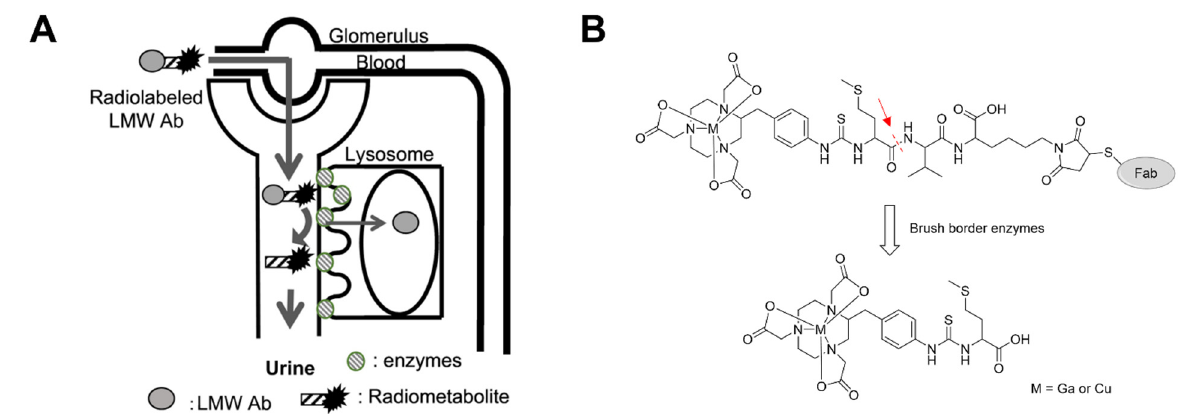
Figure 3. Renal brush border enzyme strategy. ( A ) The renal radioactivity levels of radiolabeled low molecular weight (LMW) Abs are reduced from early post-injection time by liberating a radiolabeled compound (radiometabolite) of urinary excretion from the parental LMW Abs by enzymes on the renal brush border membrane. Reprinted with permission from ref. [55]. Copyright 2021 Elsevier Inc. ( B ) Example of a cleavable linker that can be incorporated into radiopharmaceutical design. The scissile bond, shown in red, is cleaved by enzymes found on renal brush borders leading to the excretion of a radiometabolite.